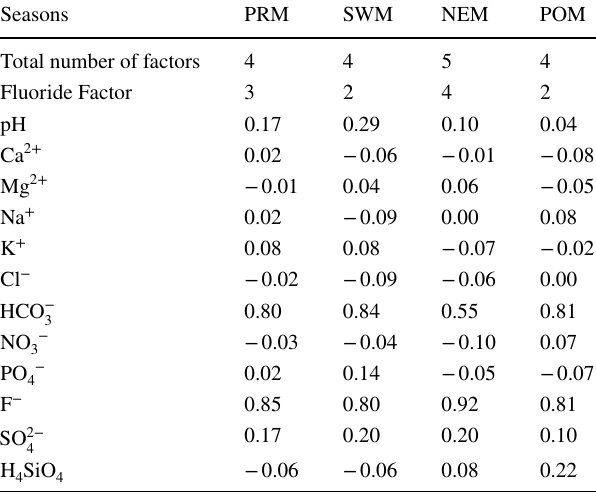
Table 2 Summary of fluoride represented factors during different periods of the